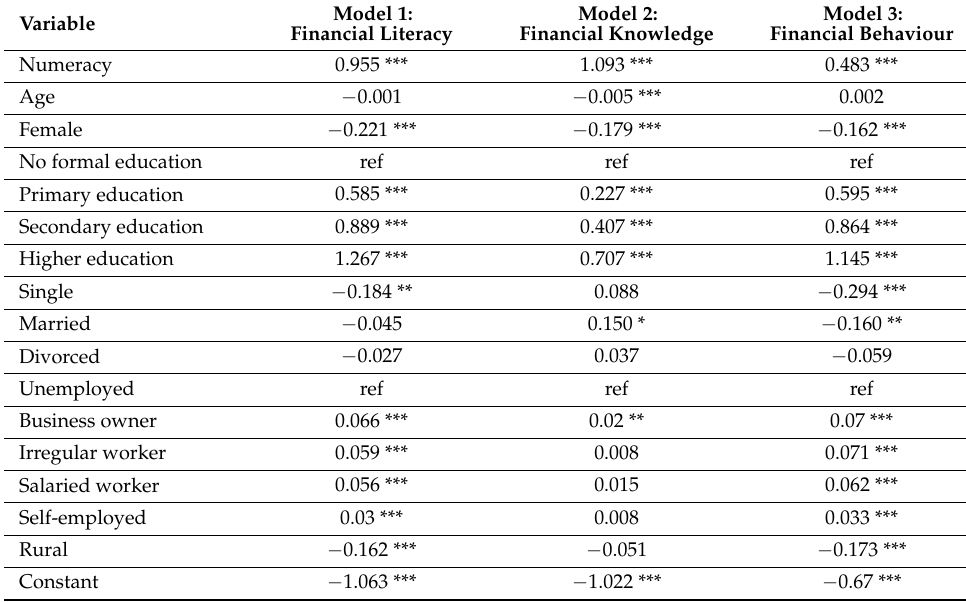
Table 2. Determinants of financial literacy in Kenya—OLS results.